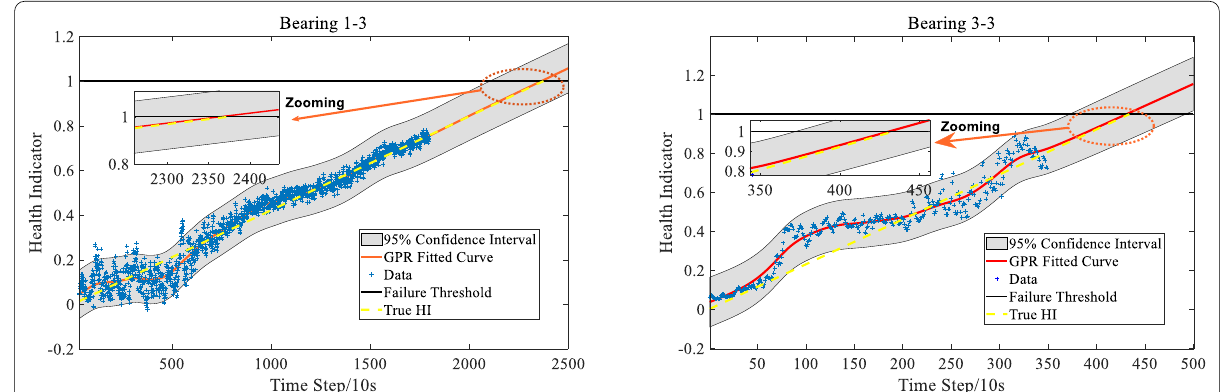
Figure 11 RUL estimation results of bearings 1-3 and 3-3 (Solid black line refers to failure threshold; blue dots represent output data of 3DCNN model; gray interval shows 95% confidence interval predicted by GPR, and solid red line shows mean of this confidence interval. Intersection of black and red lines represents failed node. Dotted yellow line represents true